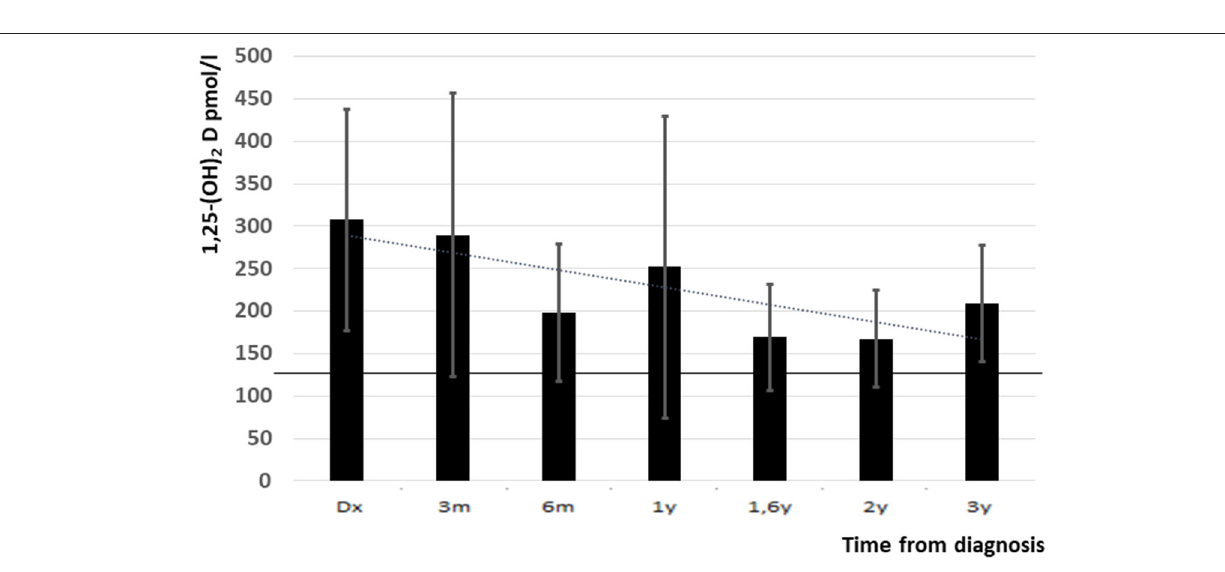
FIGURE 3 | 1,25-(OH) 2 D levels from diagnosis and up to 3 years follow up (upper normal level is indicated with black line). Y, years, m,